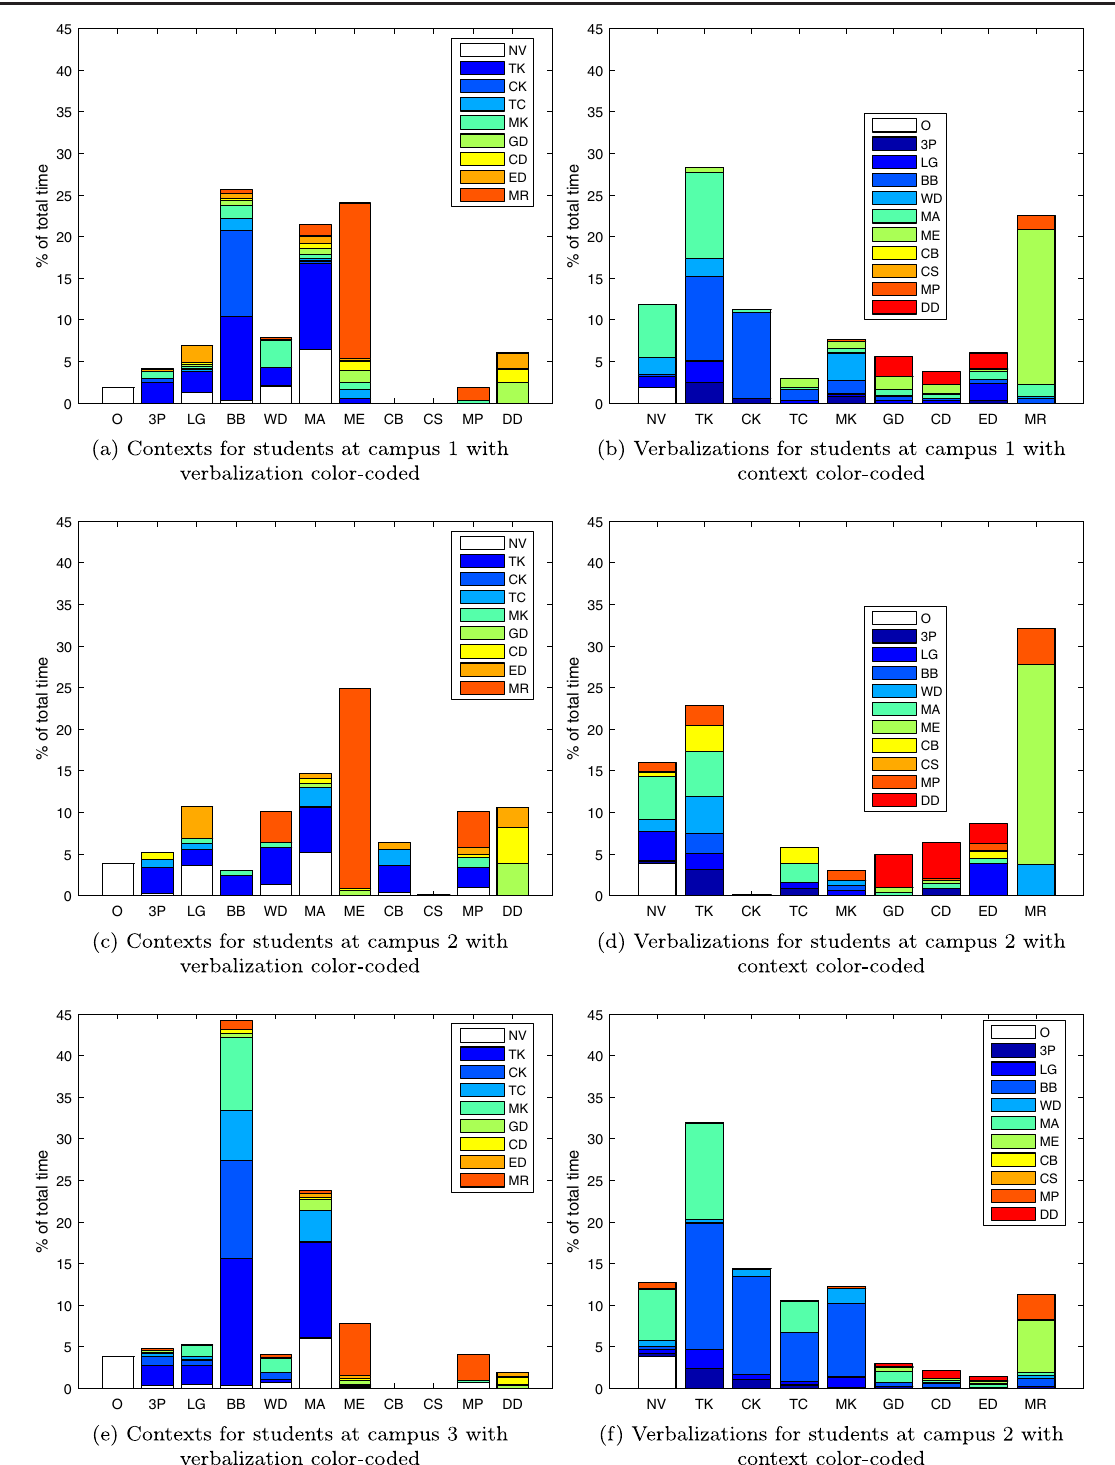
FIG. 3. Results of original labs. All percentages are the total of all pairs at the different campuses. Left are contexts in bins with verbalization marked by colors (a), (c), and (e), while right are verbalizations in bins with the contexts marked by colors (b), (d), and (f). The rows are campus 1 [(a) and (b)], 2 [(c) and (d)], and 3 [(e) and (f)],